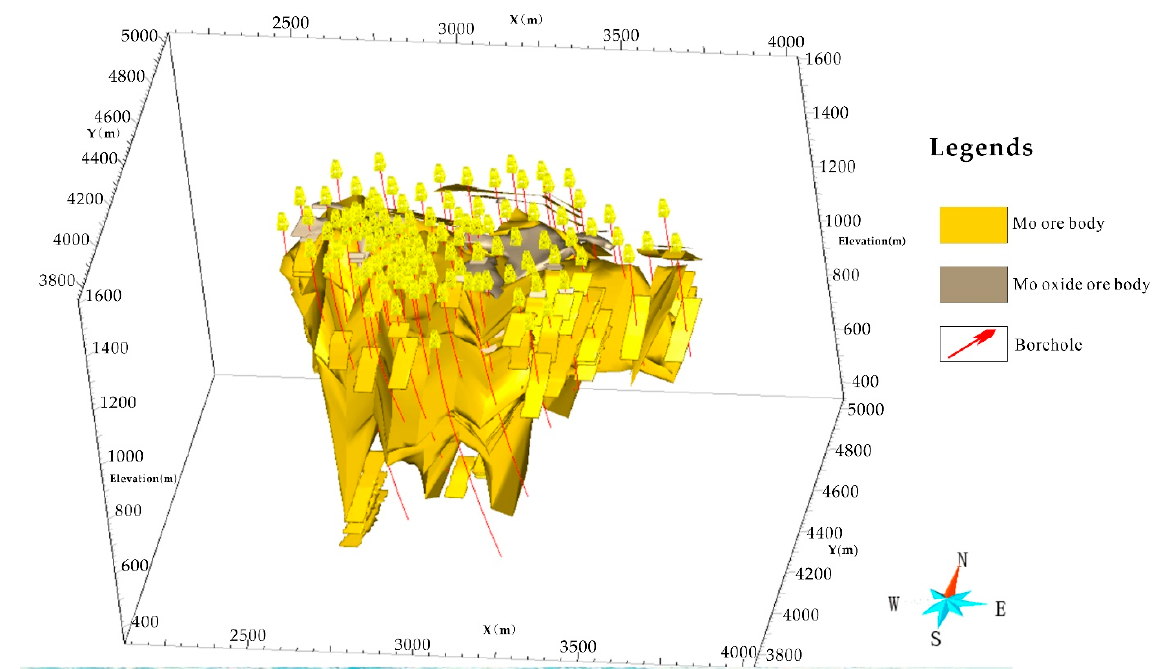
Figure 7. 3D model of Mo orebodies and Mo oxide